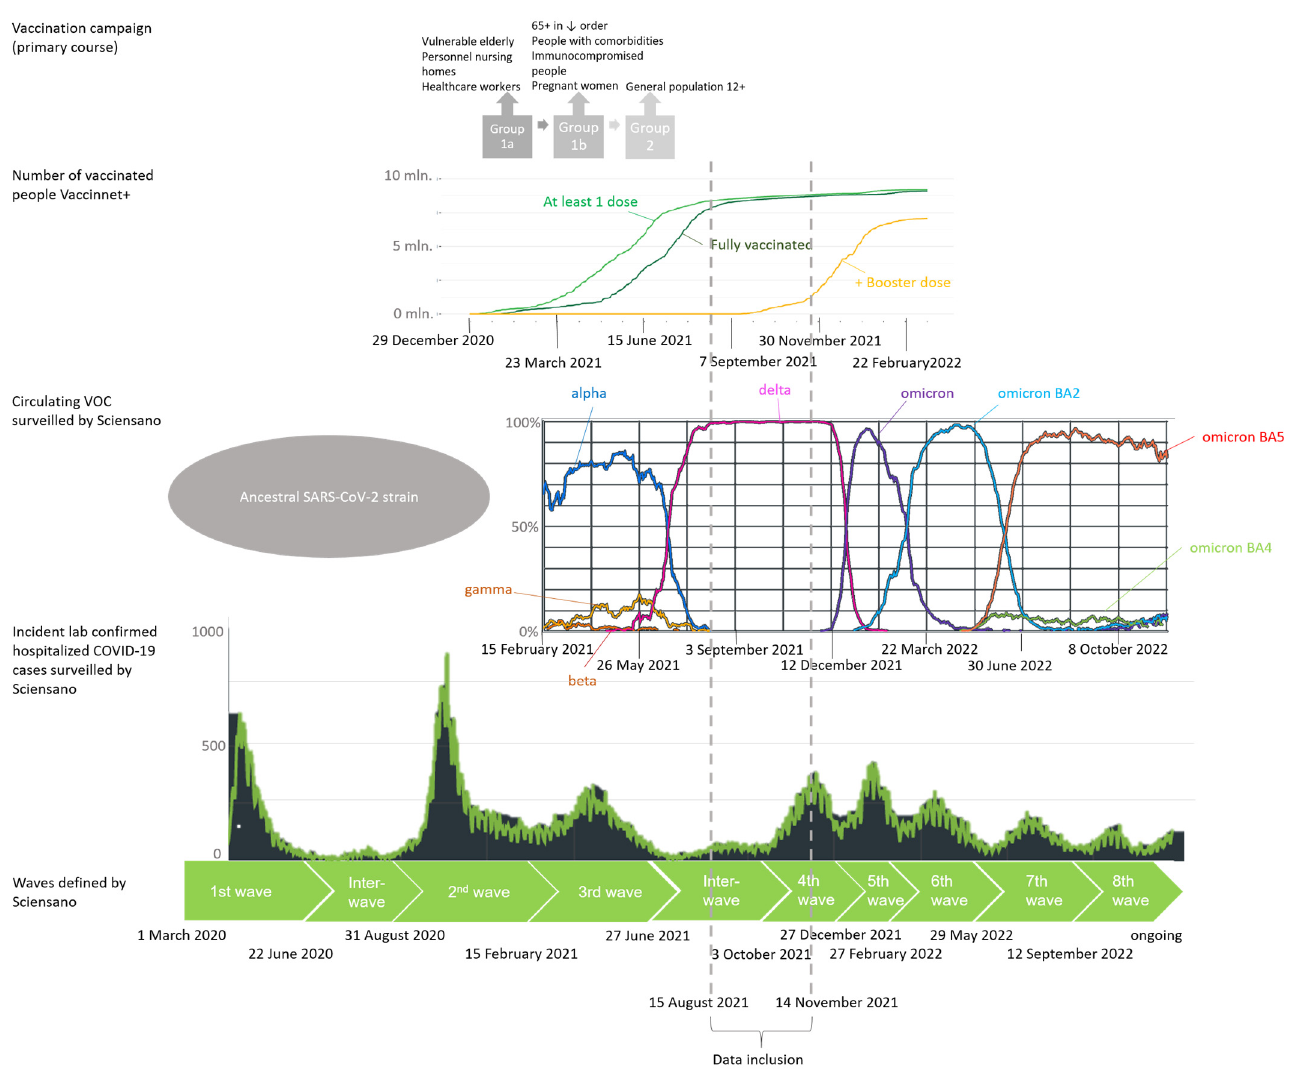
Figure 1. COVID-19 epidemiologic situation in Belgium: timeline. Schematic view of different waves in the COVID-19 epidemic in Belgium determined by circulating variants of concern (VOCs), implemented measures of restriction, number of diagnosed cases, number of hospitalizations, number of occupied beds in the hospitals and intensive care units (ICU) and speed of increase in cases [8,31]. The original Belgian vaccination campaign that started in January 2021 and stagnation of second dose delivery in August 2021 is included to indicate which high-risk groups received priority in exposure to the vaccines [5] (p. 39). Vaccine uptake: light green line: at least 1 dose; darker green line: fully vaccinated; yellow: additional booster dose. VOC: dark blue line: Alpha strain; orange line: Beta strain; yellow line: Gamma strain; pink line: Delta strain; purple line: Omicron strain; teal blue line: Omicron BA2 strain; light green line: Omicron BA4; red line: Omicron BA5.